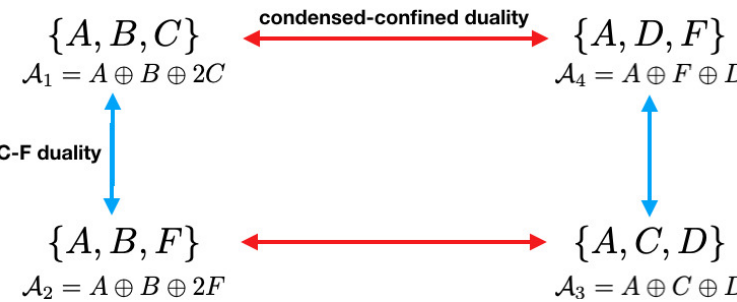
Figure 5 . The 4 boundary condensates of D ( S 3 ) Dijkgraaf-Witten model, related by the C $ F duality and the condensed-con(cid:12)ned